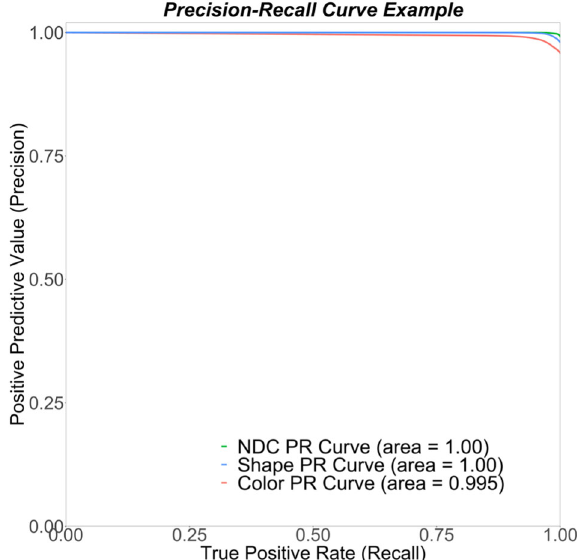
Fig. 1 Precision-recall curves for prediction of medication image components. AUC-PR is used as a measure of how well the classi fi er distinguishes between classes. In our work, the higher the AUC, the better the models are at predicting the NDC, color, or shape. The NDC and the shape model achieved an AUC-PR of almost 1.00 indicating that decision thresholds could be established to minimize both false-positive and false-negative